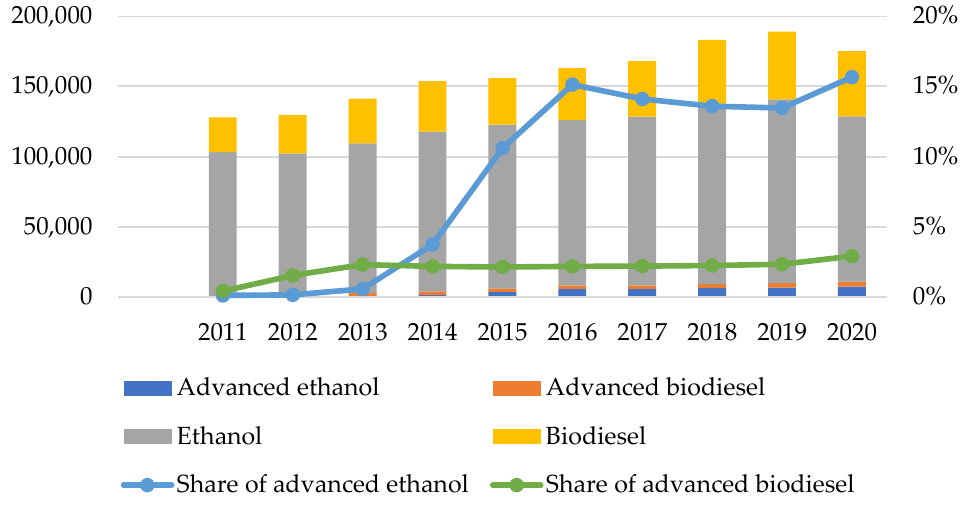
Figure 1. World ethanol, biodiesel, and advanced biofuel production in million liters, 2011 – 2020. Source: authors’ composition based on [16] .